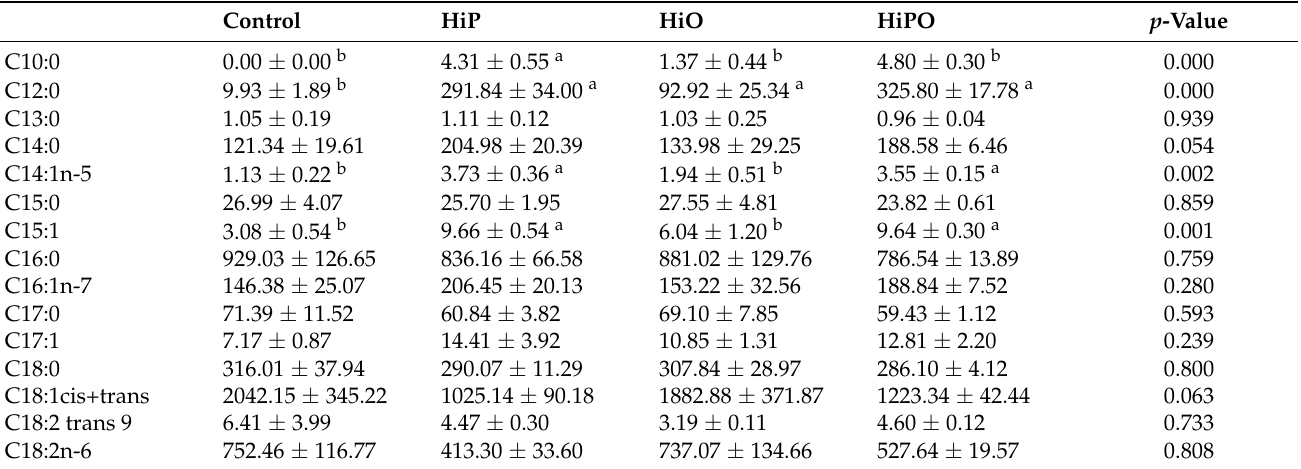
Figure 5. Total fatty acids composition ( a , b ) and lipid indexes ( c , d ) in the muscle of barramundi fed partially defatted BSF larvae protein and oil as FM protein and oil replacement diet. Data were expressed as mean ± SE, n = 3. Bar holding different indications denote significant level among the experimental treatments (one-way ANOVA; Tukey post-hoc test; ns, not significant at p > 0.05; #, significant at p < 0.05). Table 6. Fatty acid composition (mg/100 g of sample on DM-basis) of the muscle of barramundi fed partially defatted BSF larvae protein and oil as FM protein and oil replacement